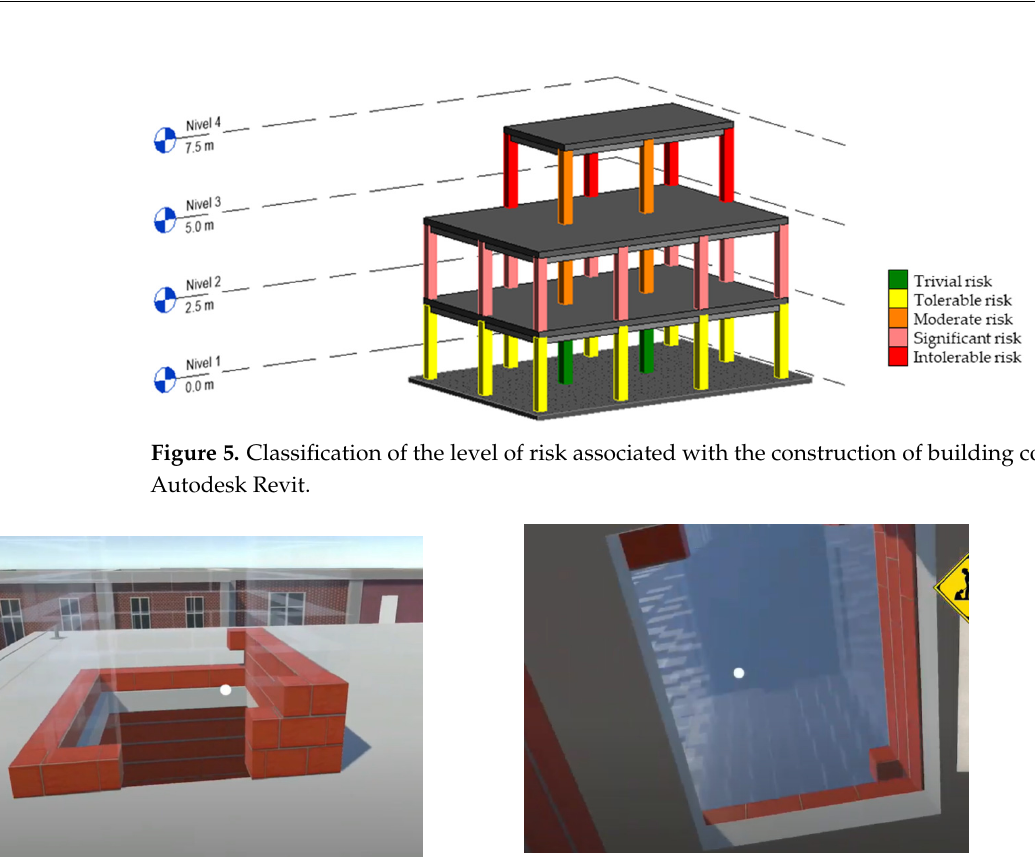
Figure 6. Programming of interaction in unsafe area ( a ) unsafe area without protection; ( b ) player’s fall.